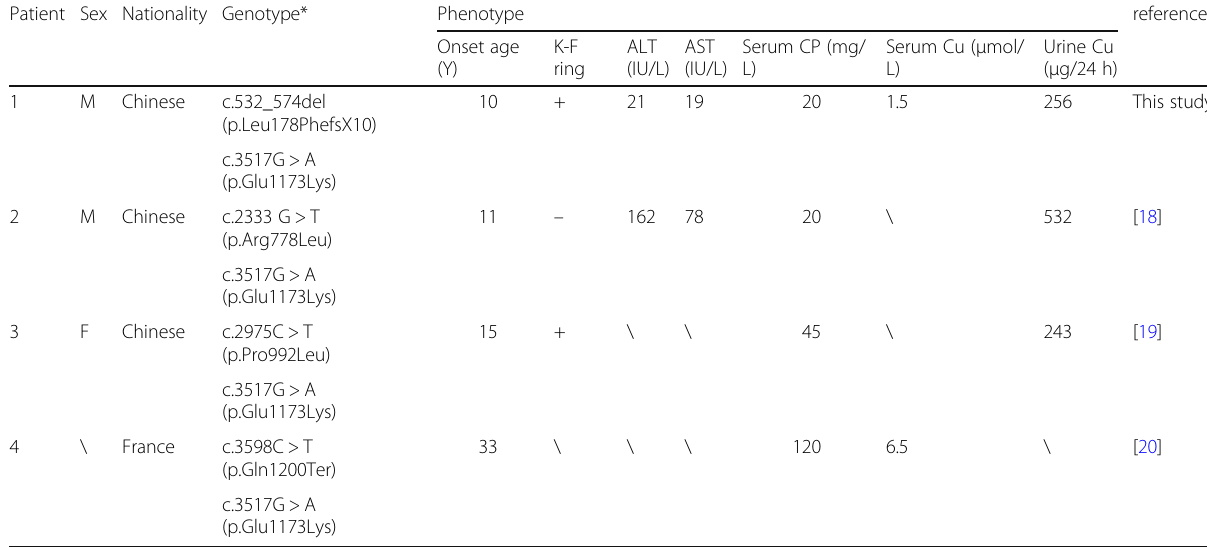
Table 1 ATP7B genotypes and phenotypes of WD patients with the c.3517G > A mutation Patient Sex Nationality